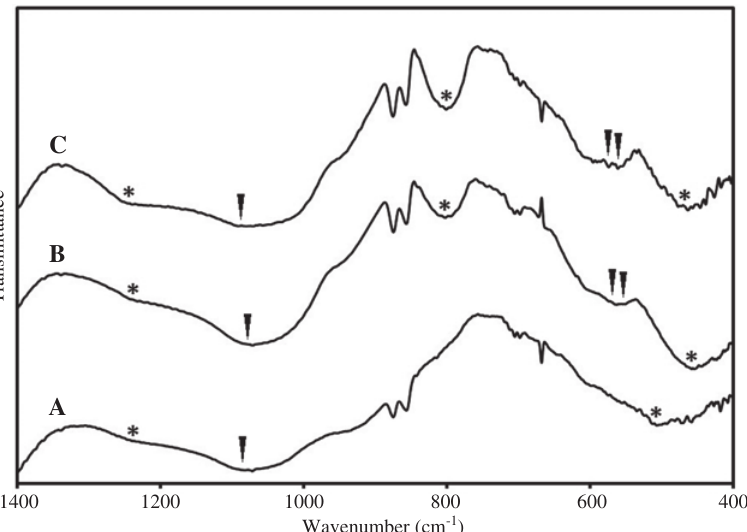
Figure 4 FTIR spectra of the composite microsphere sample before and after immersion in SBF: (A) before immersion in SBF, (B) after 7 days in SBF, and (C) after 14 days in SBF. *, silica gel; ▾,